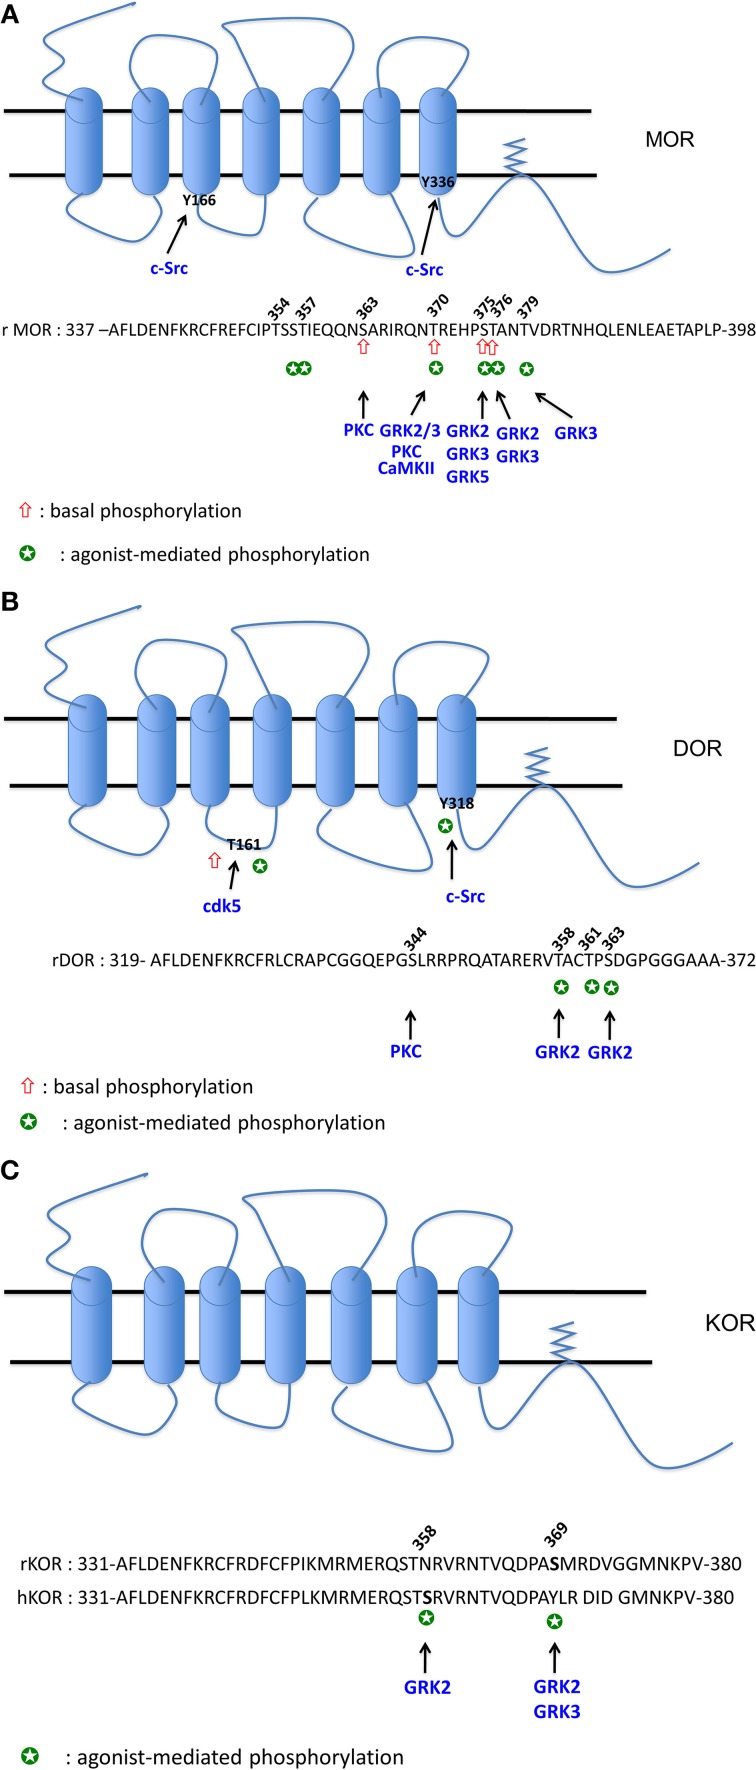
(A) Phosphorylation sites of MOR. The cluster 354TSST357: phosphorylation both by DAMGO and morphine (Lau et al., 2011). The S356 (equivalent to Ser358 in human) is phosphorylated by DAMGO (Moulédous et al., 2012), S356 and T357 are phosphorylated both by DAMGO and morphine (Chen et al., 2013). The S363 (equivalent to S365 in human) is phosphorylated in the absence of agonist (El Kouhen et al., 2001; Lau et al., 2011; Moulédous et al., 2012; Chen et al., 2013). PKC was demonstrated to phosphorylate S363 (Chen et al., 2013; Illing et al., 2014). The T370 (equivalent to T372 in human) is phosphorylated in the absence of agonist (Moulédous et al., 2012; Chen et al., 2013). A decrease of phosphorylation level is observed upon DAMGO and 1Dme (a neuropeptide FF analog) exposure (Moulédous et al., 2012). PKC (Illing et al., 2014) and CaMKII (Chen et al., 2013) phophorylate T370. DAMGO, morphine and etonitazene increase phosphorylation at T370 (Doll et al., 2011; Lau et al., 2011). DAMGO-mediated phosphorylation at this residue is ultra-rapid (20 s) (Just et al., 2013) and involves GRK2 and 3 (Doll et al., 2012) but not PKC (Illing et al., 2014). The cluster 375STANT379 displays higher level of phosphorylation upon DAMGO compared to morphine (Lau et al., 2011). S375 or T376 (equivalent to S377 and T378 in human) are phosphorylated upon DAMGO and 1Dme (Moulédous et al., 2012), DAMGO, etonitazene, and morphine (Doll et al., 2011). S375 is considered as the major phosphorylation site as it is rapidly phosphorylated (20 s) upon DAMGO (Just et al., 2013). This agonist-mediated phosphorylation does not implicate PKC (Illing et al., 2014) but rather GRK2 (Chen et al., 2013) or GRK2 and 3 (Doll et al., 2012) upon DAMGO exposure, and GRK5 and to a lesser extent GRK3 upon morphine treatment (Doll et al., 2012). T376 (equivalent to T378 in human) is phosphorylated upon DAMGO and 1Dme (Moulédous et al., 2012), by GRK2 and 3 upon DAMGO exposure but it is considered as a late phosphorylation site (20 min) (Just et al., 2013). T379 is also phosphorylated upon DAMGO exposure after 1 min and required the GRK3 (Just et al., 2013). Y166 (Clayton et al., 2010) and Y336 (Zhang et al., 2009) are phosphorylated by Src. (B) Phosphorylation sites of DOR. S344 phosphorylation is mediated by a PKC but is not increased by DPDPE (Xiang et al., 2001). S358 and S363 (Guo et al., 2000; Kouhen et al., 2000) are the two major sites of phosphorylation mediated by GRK2 upon DPDPE exposure. Deltorphin II and morphine are also able to increase phosphorylation at S363 (Navratilova et al., 2005). T361 is phosphorylated by DPDPE but after S358 and S363 phosphorylation (Guo et al., 2000; Kouhen et al., 2000). T161 is phosphorylated by CDK5 in the absence and in the presence of chronic morphine exposure (Xie et al., 2009). Y318 is phosphorylated by Src upon DTLET exposure (Kramer et al., 2000b). (C) Phosphorylation sites of KOR. Phosphorylation of S369 (rKOR) is mediated by GRK2 (Mclaughlin et al., 2003) and 3 (Mclaughlin et al., 2004) upon U50488 exposure. In hKOR, S358 is phosphorylated by GRK2 when activated by U50488 (Li et al., 2002).